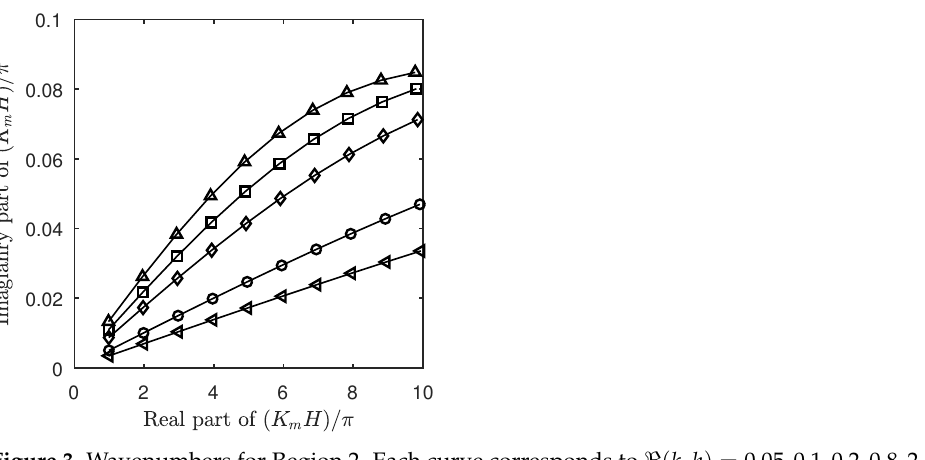
Figure 3. Wavenumbers for Region 2. Each curve corresponds to (cid:60) ( k 1 h ) = 0.05,0.1,0.2,0.8,2.5 ( (cid:52) , (cid:3) , (cid:5) , ◦ , (cid:47) ). In all cases, H / h = 0.5 and all other parameters are the same as those used in Figure